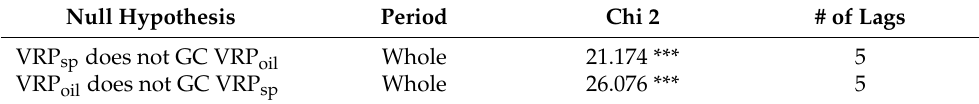
Table 5. Granger causality test (whole